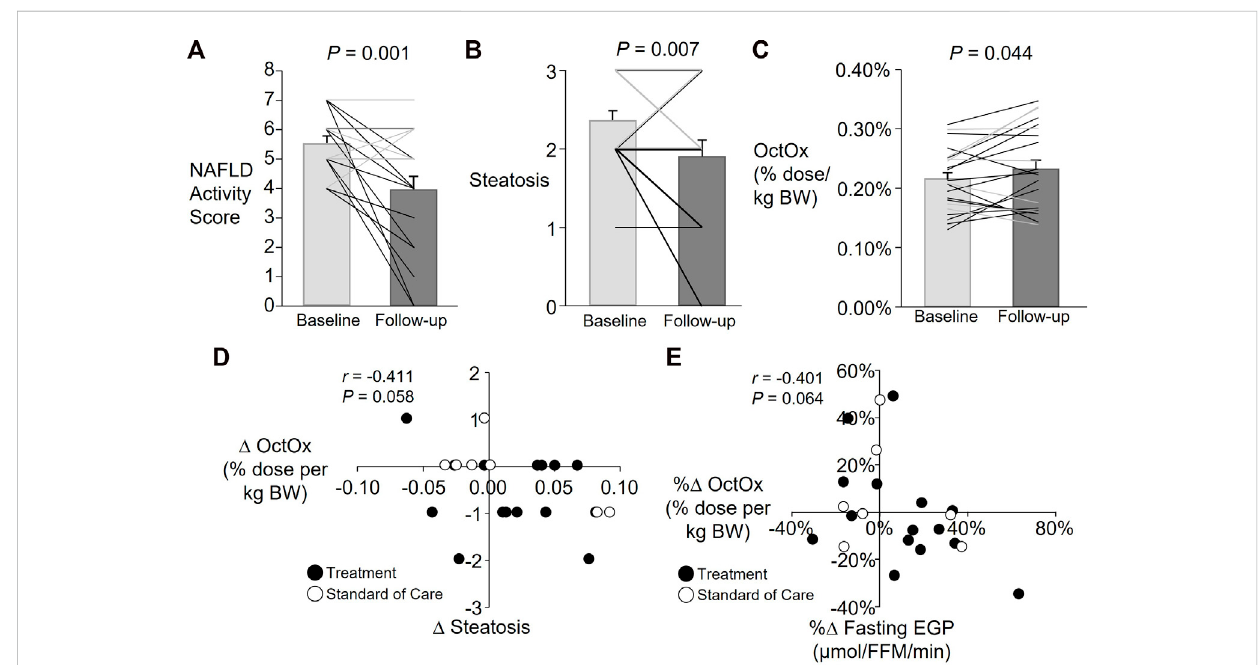
FIGURE 3 Part 2: Average and individual changes in NAFLD activity score, steatosis, and percent (%) octanoate dose oxidized (OctOx) and relationships between change inOctOx, steatosis, and glucose production. Data are presented as mean ± SEM; Lifestyle treatment: n = 15,solidblack lines and black- fi lled circles; Standard care: n = 7, solid grey lines and white- fi lled circles. Paired, one-tailed t -test for baseline to follow-up comparisons in all subjects. Note: Many individual subject lines overlap and individual data are presented in Supplementary Figure S1. (A) Changes in total NAFLD activity score. (B) Changes in the steatosis component of the NAFLD activity score. (C) Changes in OctOx, expressed as a percentage of the total dose oxidized per kg bodyweightover135 min. (D) Spearman ’ snon-parametriccorrelationbetweenabsolutechanges( Δ )insteatosisandpercent(%)doseOctOxperkgbody weight. (E) Pearson ’ s correlation between percent changes in fasting EGP (relative to fat free mass, FFM) and percent dose OctOx per kg body